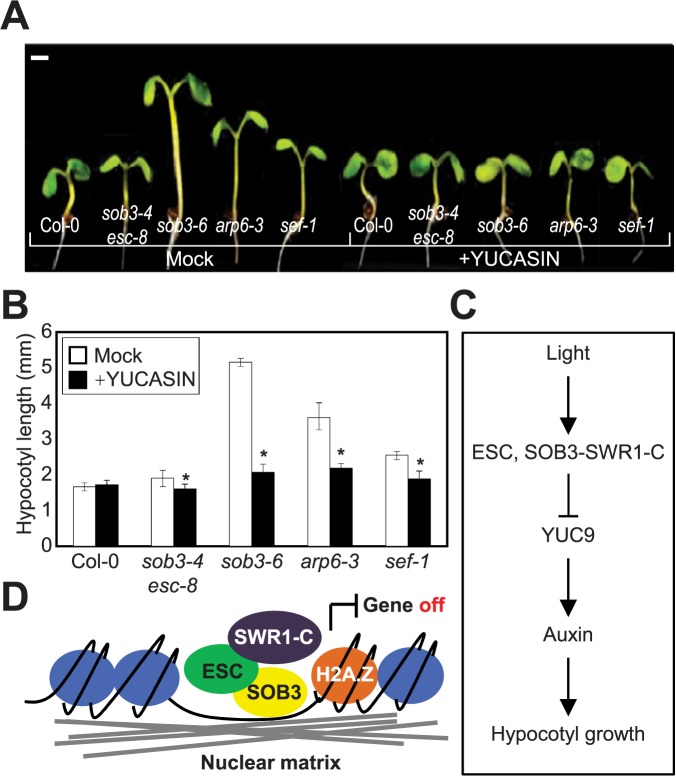
Genetic hierarchy of S/MAR-assisted H2A.Z exchange and auxin biosynthesis.(A) Effects of yucasin on hypocotyl elongation of sob3-6, arp6-3 and sef-1. Seeds were germinated on MS medium supplemented with 250 uM yucasin, and incubated for 7 days under LD conditions. Scale bar, 1 mm. (B) Quantification of hypocotyl length. Hypocotyl lengths (n > 30 in each genotype) were measured using Image J applications (http://rsb.info.nih.gov/ij/). Three independent biological replicates were averaged, and the statistical significance of the measurements was determined by two-tailed Student's t-test assuming unequal variance (*P < 0.05). Bars indicate the standard error of the mean. (C and D) Proposed working diagram. Light-inducible ESC and SOB3 bind to the YUC9 promoter and recruit the SWR1 complex that catalyzes H2A.Z exchange in order to suppress its expression. As a consequence, auxin biosynthesis is inhibited, and thus hypocotyl elongation is suppressed in light.